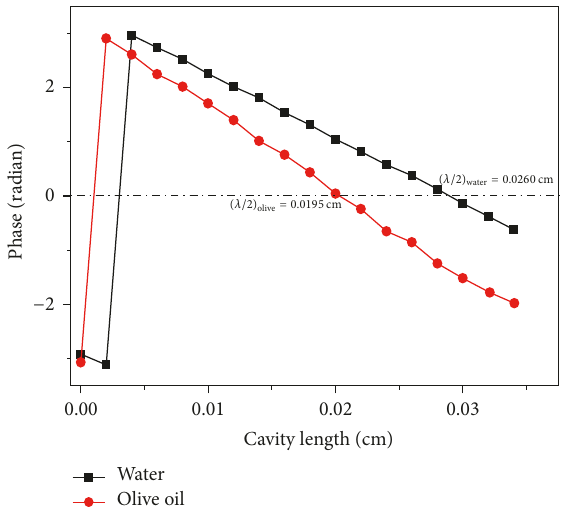
Figure 7: PE signal as a function of the cavity length for phase discontinuities for distilled water and olive oil.